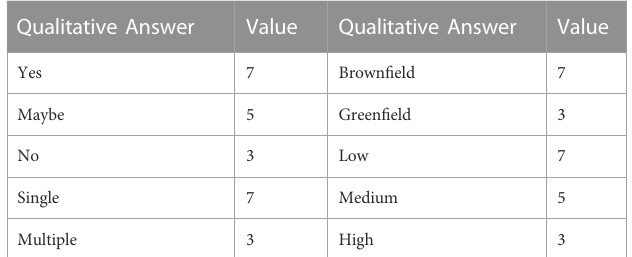
TABLE 5 Non-Numeric Answer